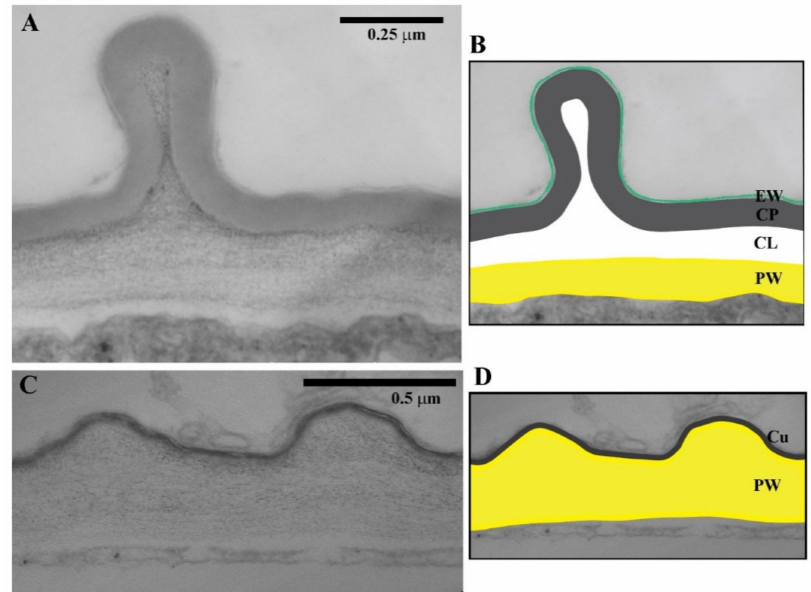
Figure 1. Cuticle on epidermis of arabidopsis sepal ( A , B ) and hypocotyl ( C , D ). Cross-sections of outer periclinal walls are shown in micrographs obtained using transmission electron microscopy. ( A , B ) Outer periclinal wall of the cell of the abaxial sepal epidermis. The cell wall layers labelled in ( B ) are: epicuticular waxes (EW); cuticle proper (CP); cuticular layer (CL); and non-cutinized primary wall (PW). The cuticle proper is folded. ( C , D ) Outer periclinal wall of an epidermal cell of the etiolated hypocotyl. The cuticle (Cu) overlying coves of the primary cell wall (PW) is very